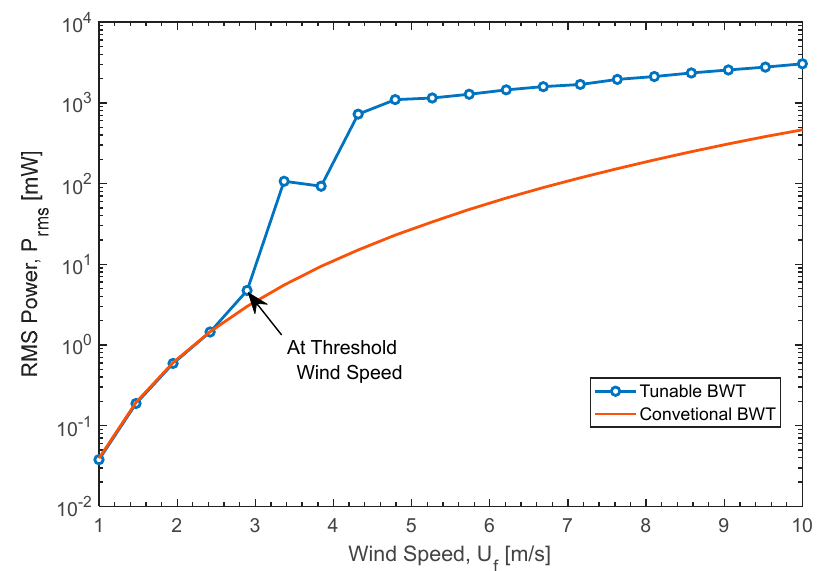
Figure 10. Output rms power of the tunable and conventional turbines as a function of the wind speeds.